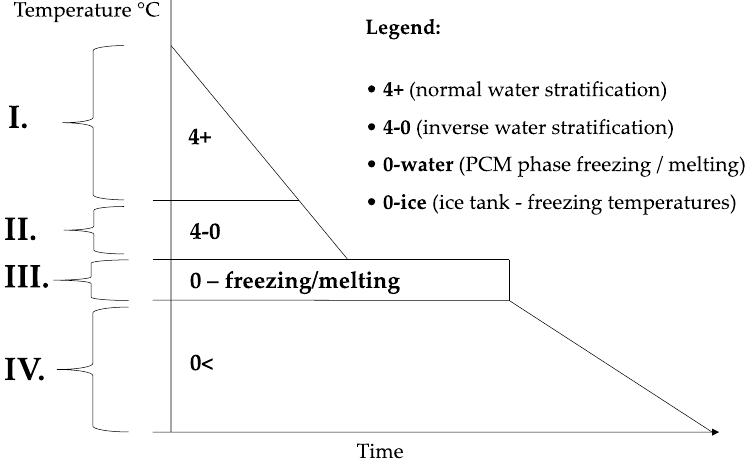
Figure 9. Expected phases of the ice storage tank.